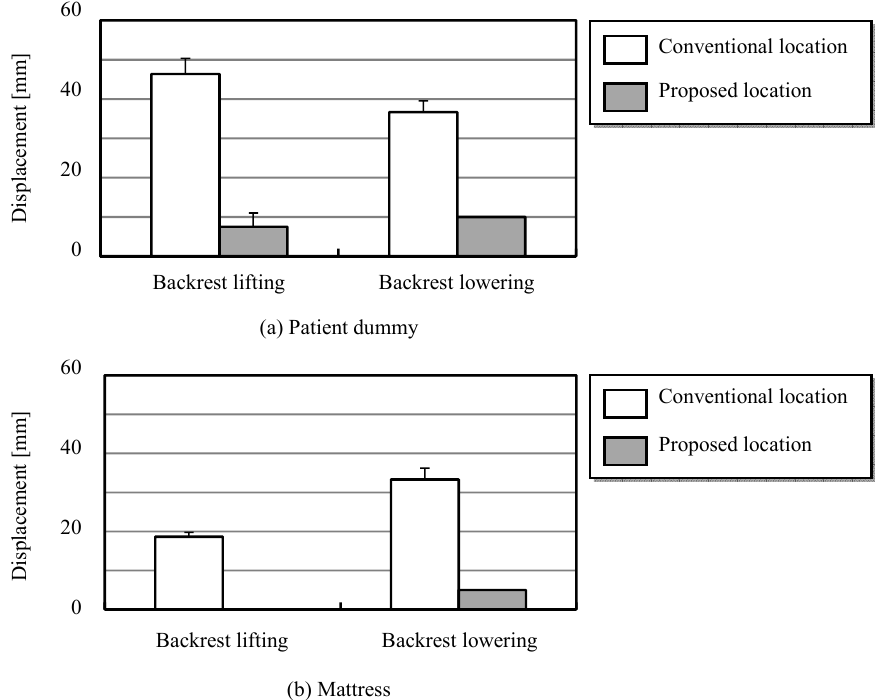
Fig. 6 Displacement after backrest lifting and